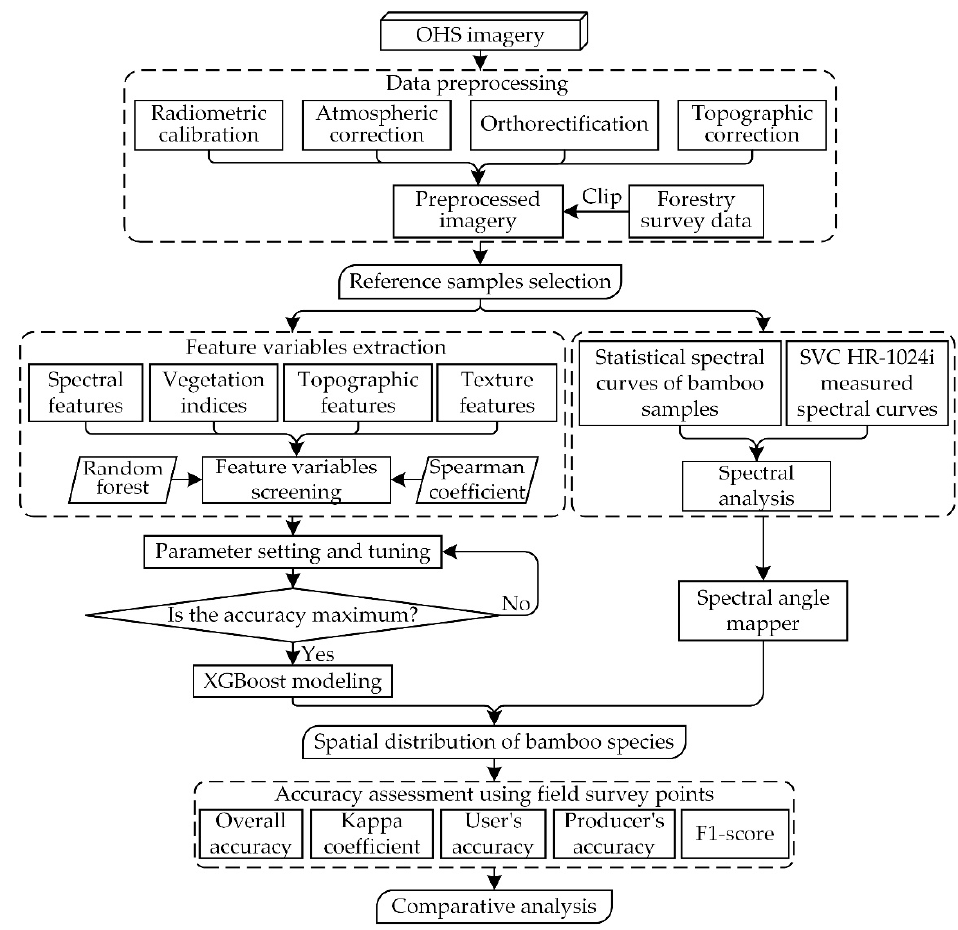
Figure 3. Bamboo species classification methodology and workflow.